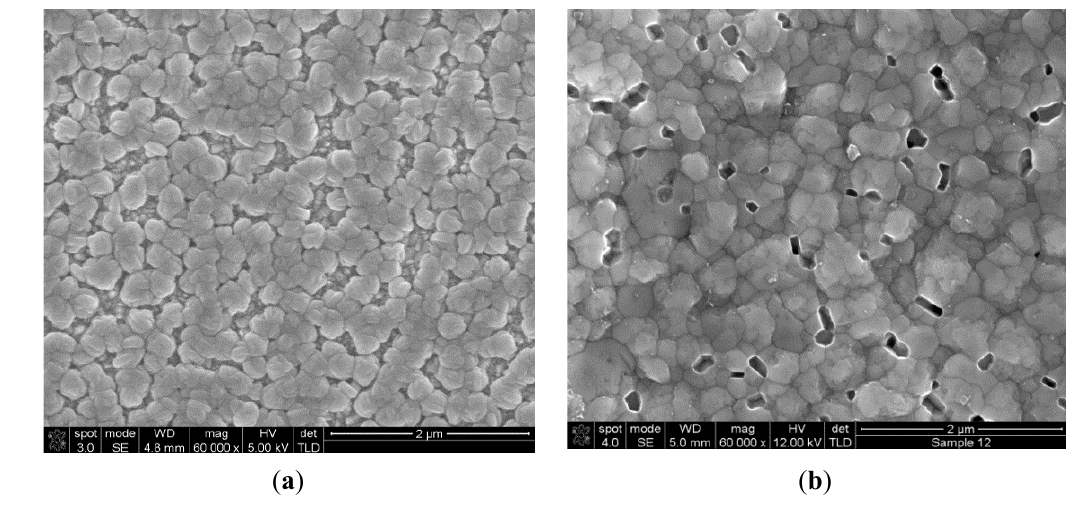
Figure 7. Typical 2D-SEM images of ( a ) electrodeposited CdS on glass/FTO substrate and ( b ) electrodeposited CdTe on glass/FTO/CdS